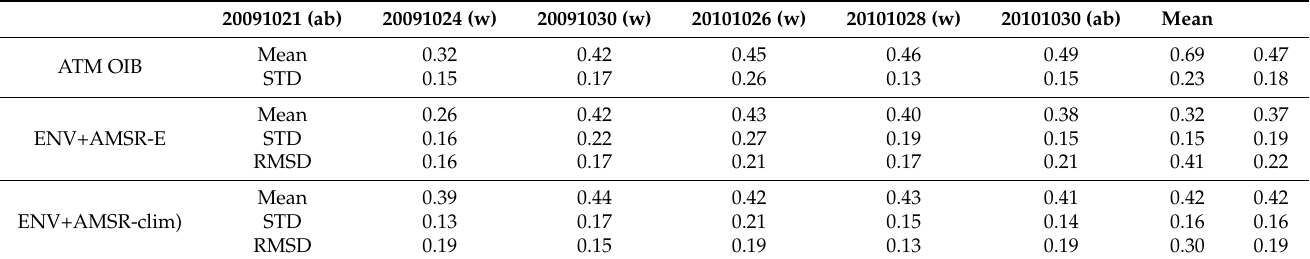
Table 4. Comparison between mean OIB ATM total freeboards and Envisat drafts computed over 2003–2011. Envisat drafts are computed from the AMSR-E and AMSR-clim snow depths. (ab) indicate that the mission occurred in the coA-B sector and (w) in